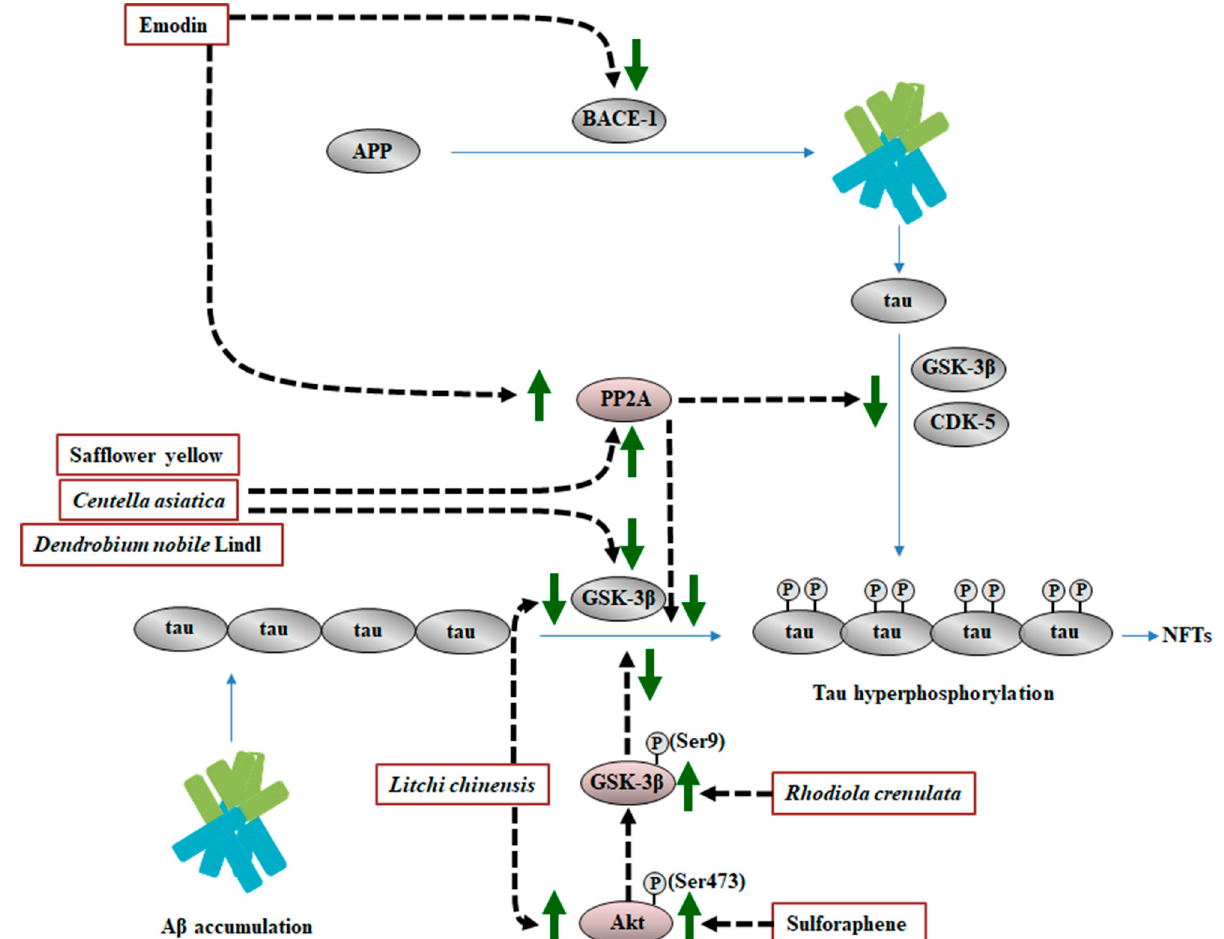
Figure 3. Schematic representation of the effects of MHDIs on A β -induced tau hyperphosphorylation in the hippocampus in the early and late phases of AD in in vivo models. P, phosphorylated.